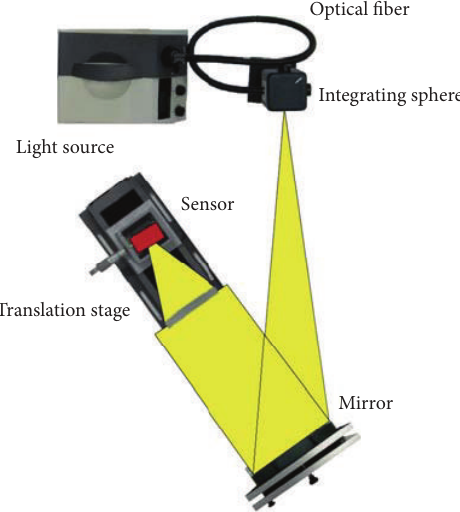
Figure 11: Practical realization of configuration L1 (for large com- ponents).